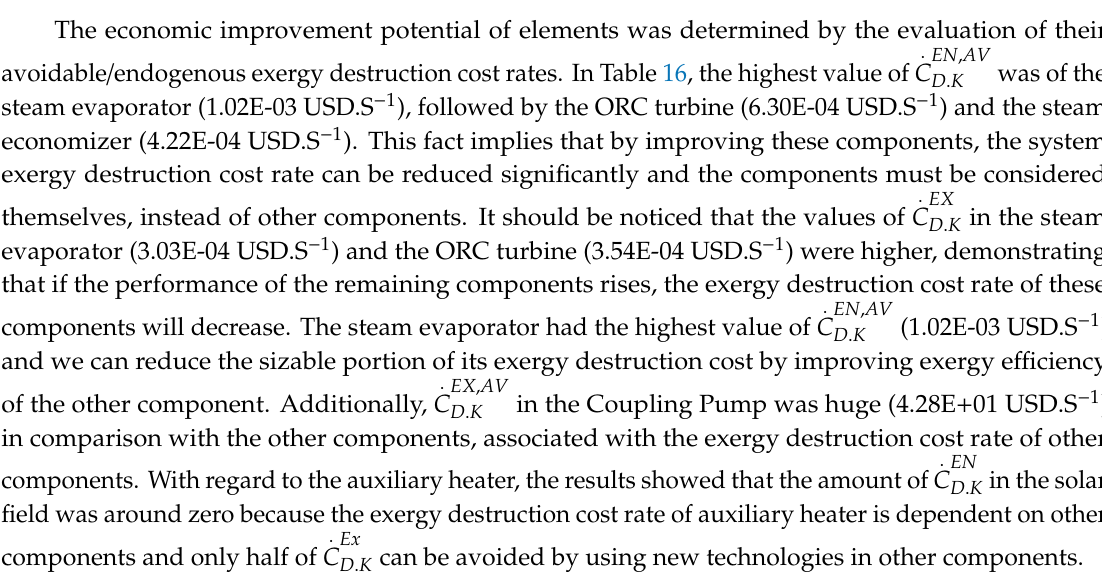
Table 18 indicates the results of the advanced exergo-environmental analysis for the SGPP